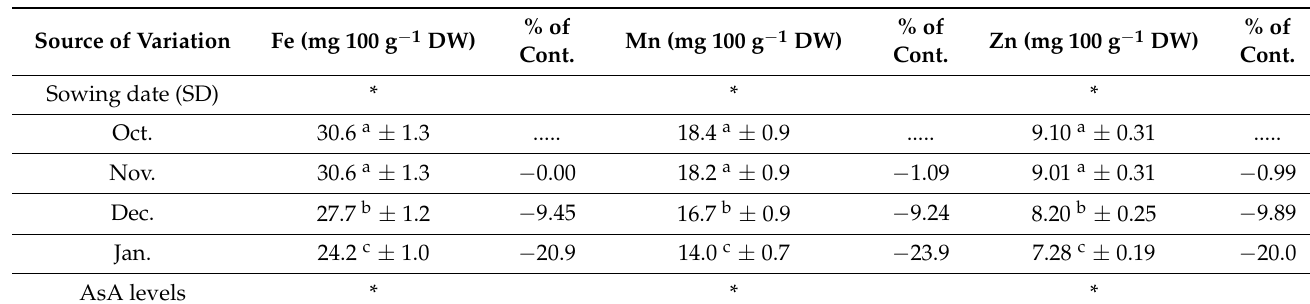
Table 4. Effect of integrative treatment of seeds and leaves with ascorbic acid (AsA) on micronutrient contents of parsley plants under different sowing dates vs. October. All values are the average of